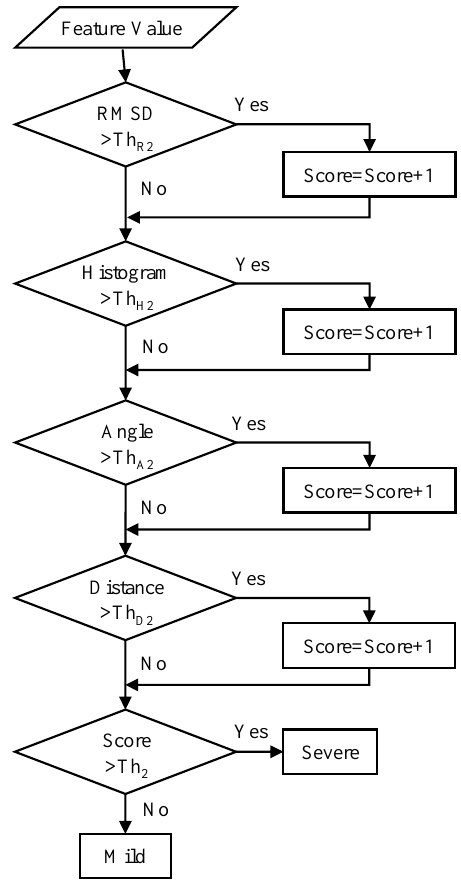
Figure 9. Algorithm for measuring severity in cerebellar disorders ( CD) patients.